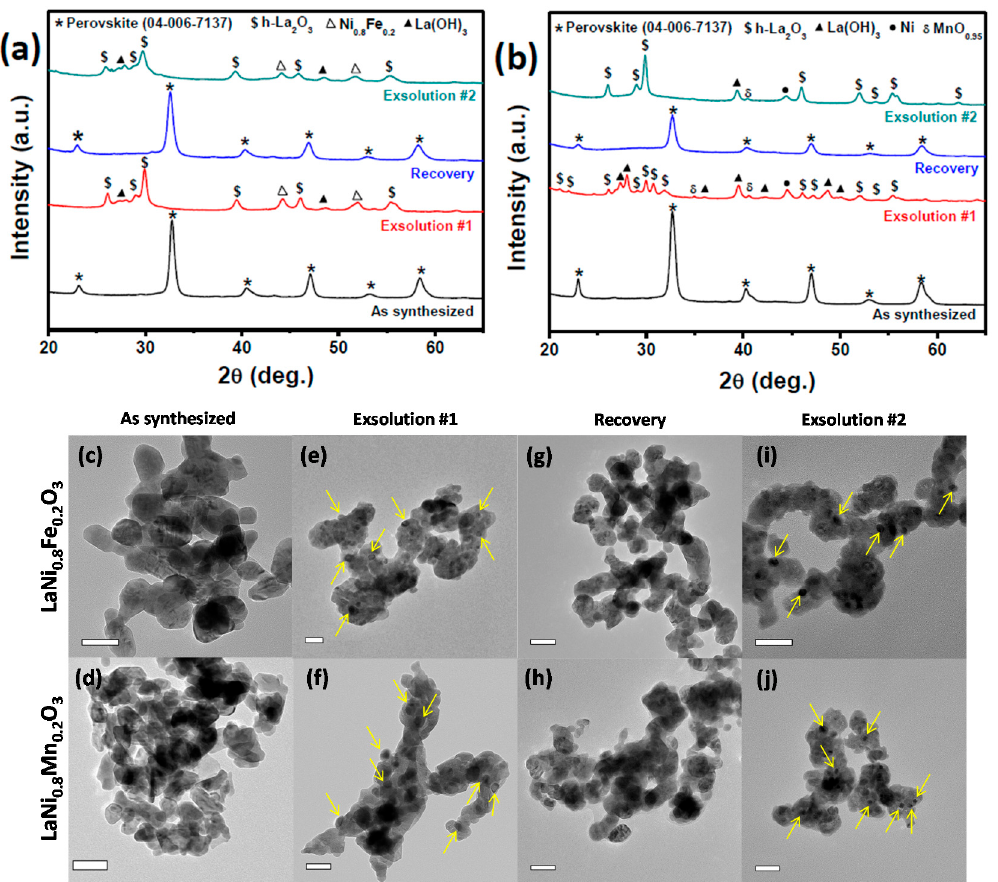
Figure 3. XRD patterns after exsolved and recovered catalysts ( a ) LaNi 0.8 Fe 0.2 O 3 perovskite; ( b ) LaNi 0.8 Mn 0.2 O 3 perovskite; TEM images of as synthesized; ( c ) LaNi 0.8 Fe 0.2 O 3 ; and ( d ) LaNi 0.8 Mn 0.2 O 3 perovskites ( e , f ) after first exsolution, ( g , h ) after recovery in oxygen for 8 h at 800 °C ( i , j ) second exsolution after recovery. Few exsolved NiFe/Ni nanoparticles in both perovskites after each exsolution step are marked by yellow arrows. Scale bars in all TEM images are 50 nm. Table 1. XRD Domain Size from Reitveld Analysis